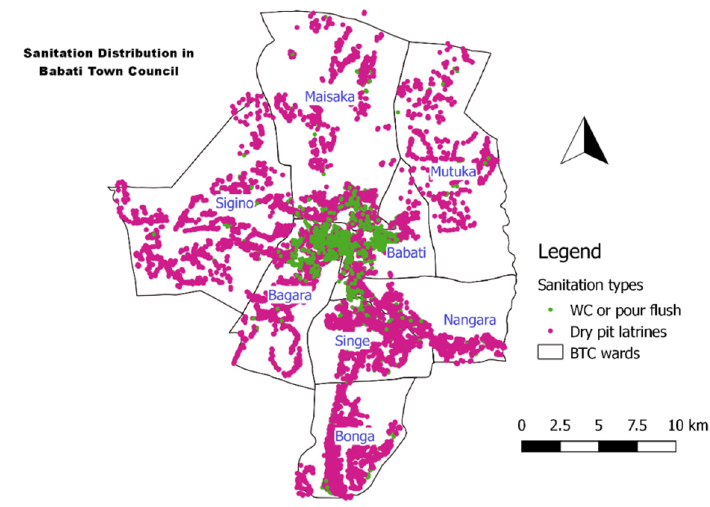
Figure 4. Distribution of dry and wet sanitation in Babati Town Council.